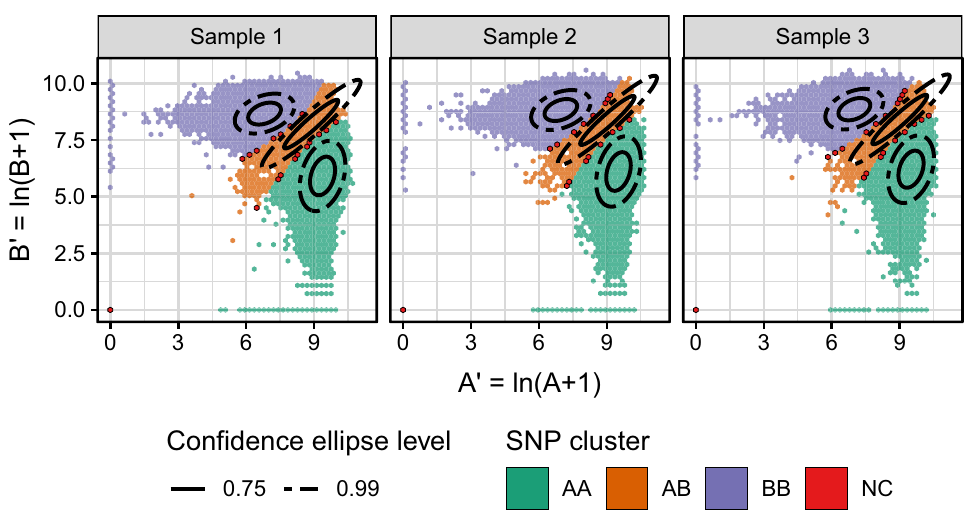
Figure 3. The SNP calling for the “Butterfly (sample)” method illustrated for samples with 400 ng DNA. An a posteriori probability threshold of 0.8 was applied for NC. Note, that the NCs are in the regions between two SNP groups and at (0, 0), and the NC regions are small compared to those of the SNP